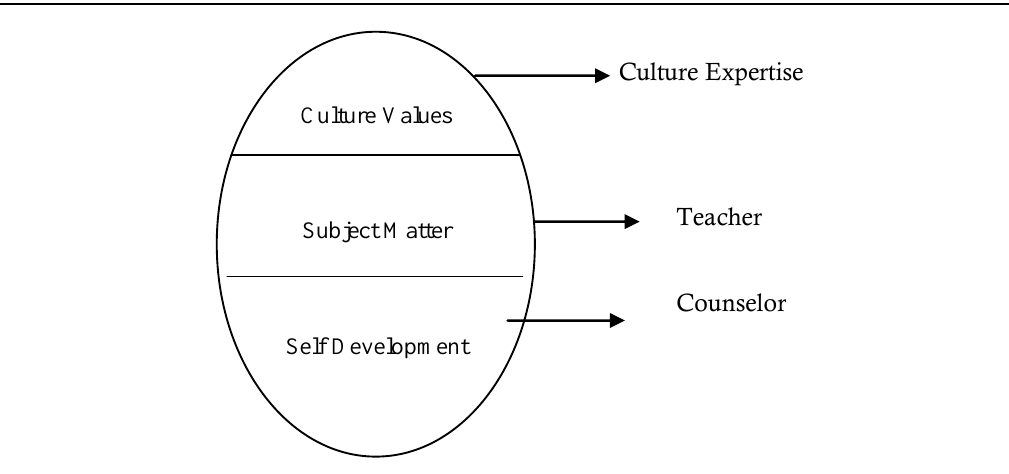
Figure 1. Counseling Position In Circle of Education